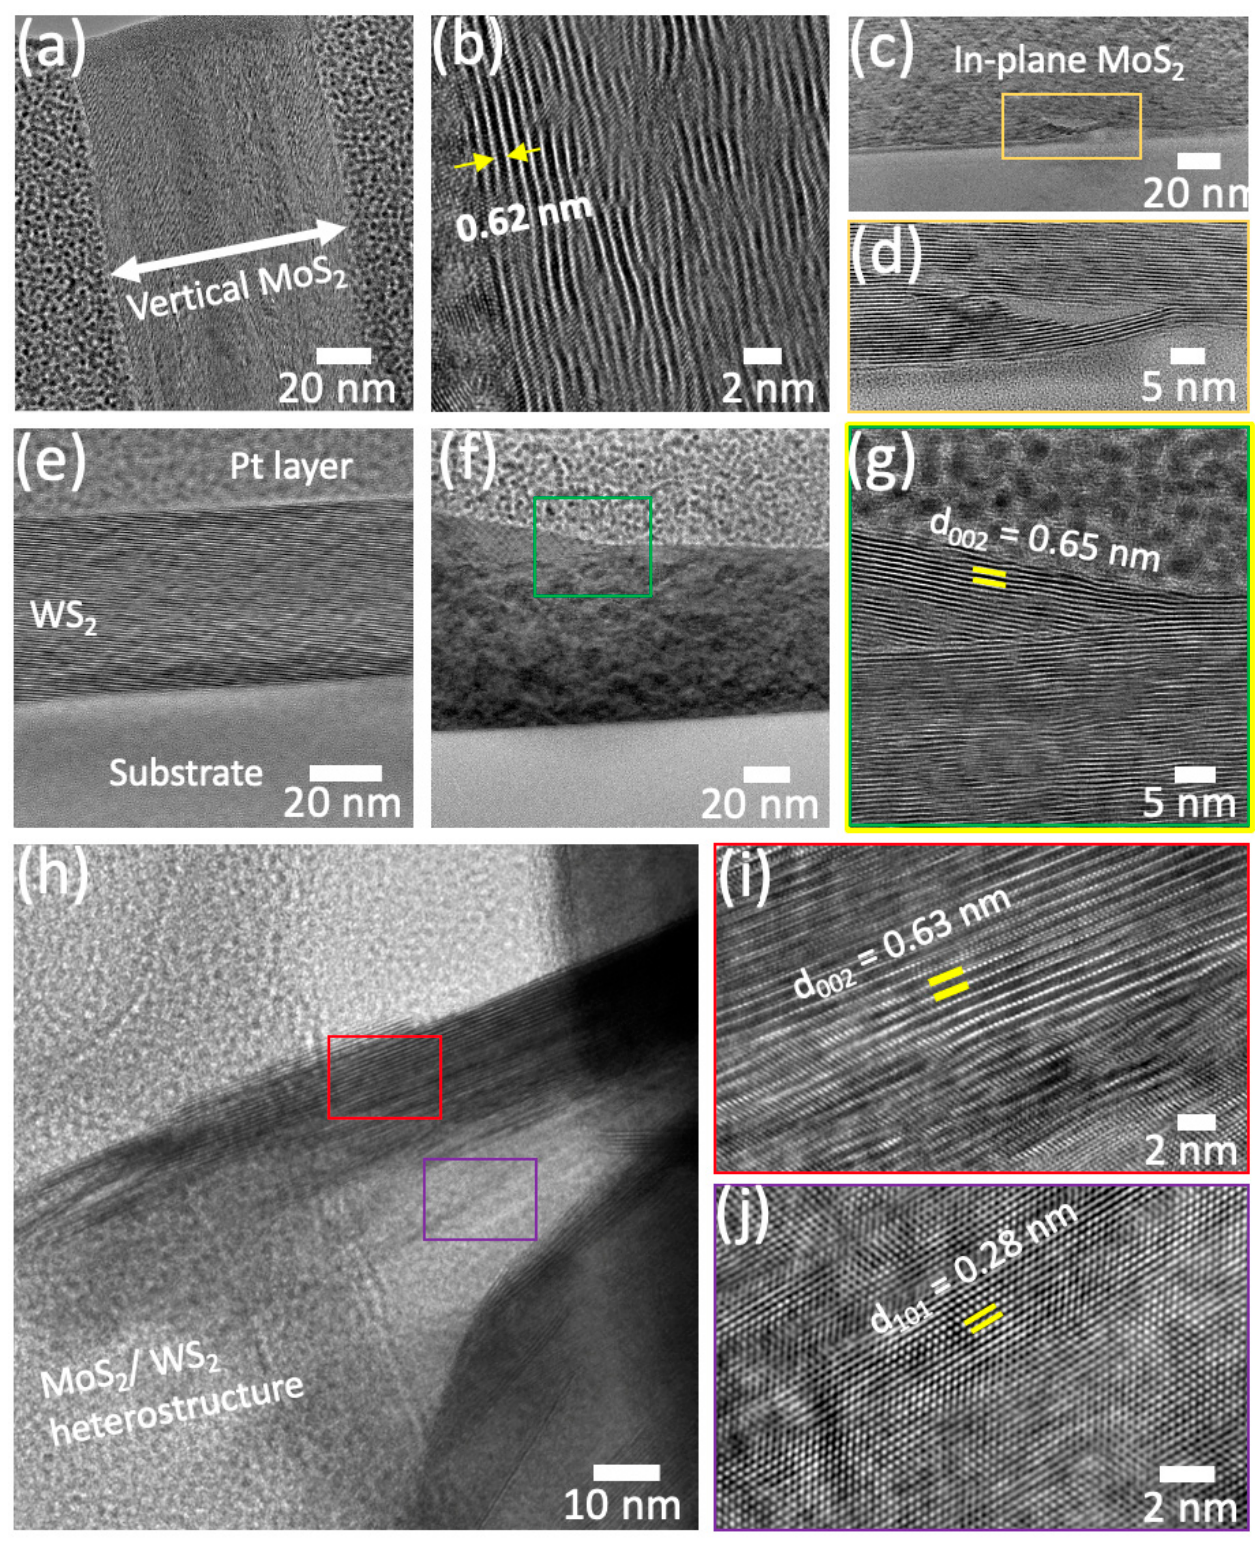
Figure 5. Typical TEM microstructure at low and high magnifications. ( a , b ) Cross-sectional bright field TEM images of vertically oriented MoS 2 flakes; ( c , d ) TEM image of in-plane MoS 2 ; ( e – g ) cross-sectional views of deposited multi-stacked WS 2 layers; ( h – j ) bright-field image of the Mo x W 1-x S 2 heterostructure.